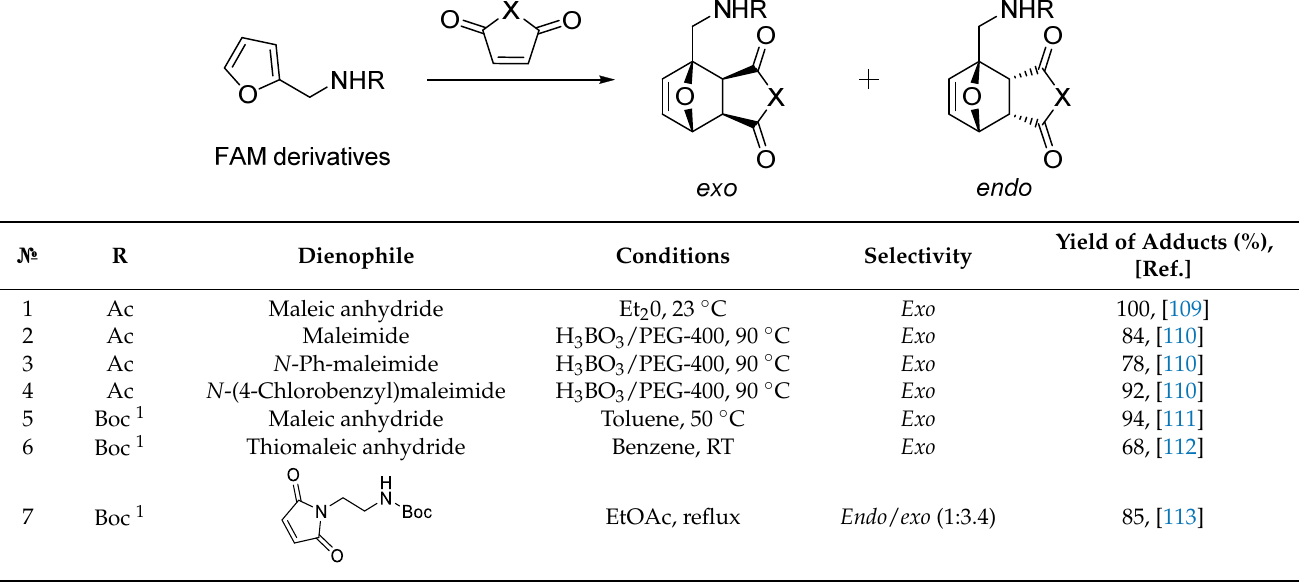
Table 7. Direct DA reaction of furanic aldehydes with maleimides in water medium